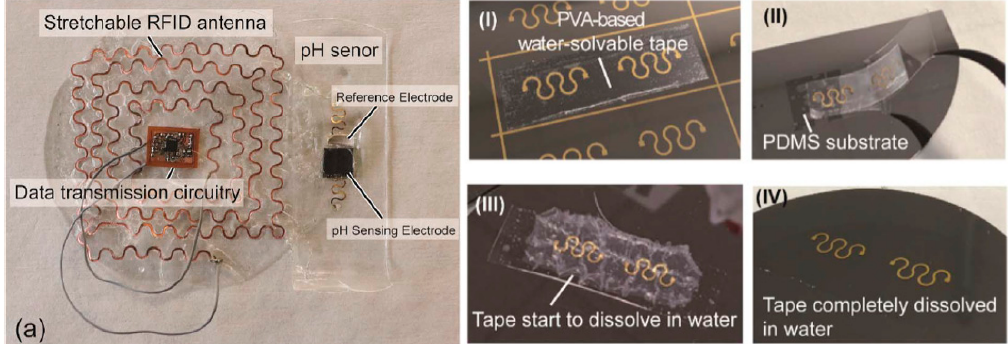
Figure 19. ( a ) Photograph of the stretchable wireless antenna, data transmission circuit and sensor. Right: steps of the transfer protocol of the circuits from Si wafer to PDMS. Reproduced from [63] with permission. © 2018 Elsevier B.V. All rights reserved.